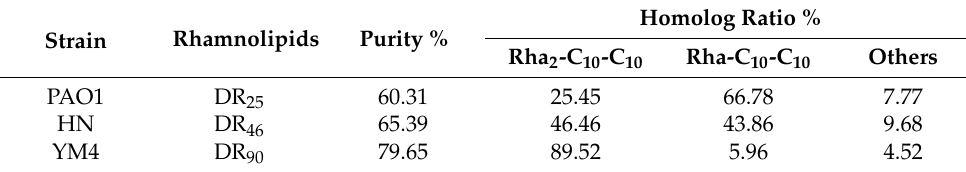
Figure 1. HPLC characterization of three rhamnolipid products. Table 1. The components and purity of rhamnolipid products.